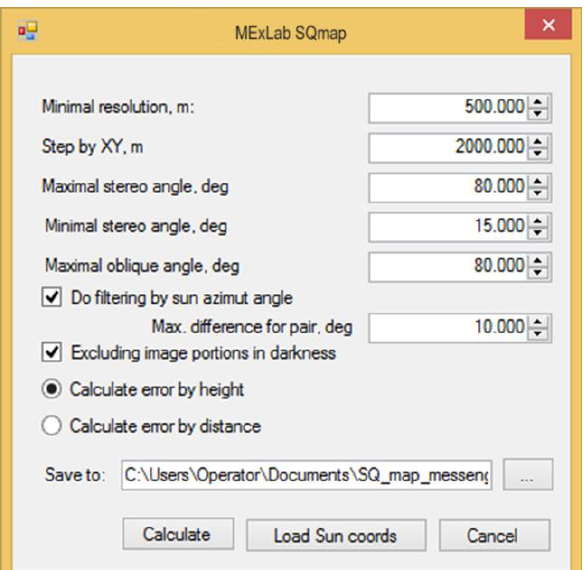
Figure 7. User interface of the SQmap